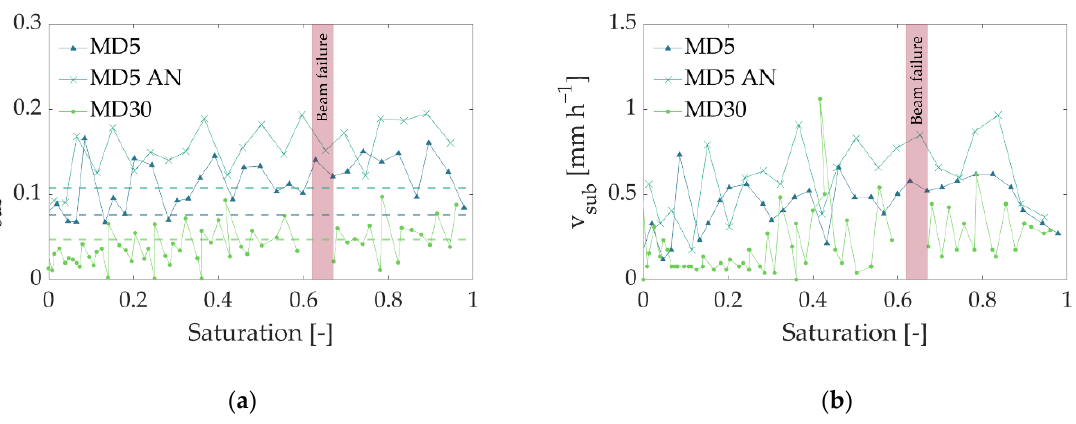
Figure 8. ( a ) Comparison of sublimation fluxes. The beam failure occurred in experiment 3 (MD30) and is marked by the red bar. ( b ) Velocity of sublimation fronts, calculated from the mean front positions.